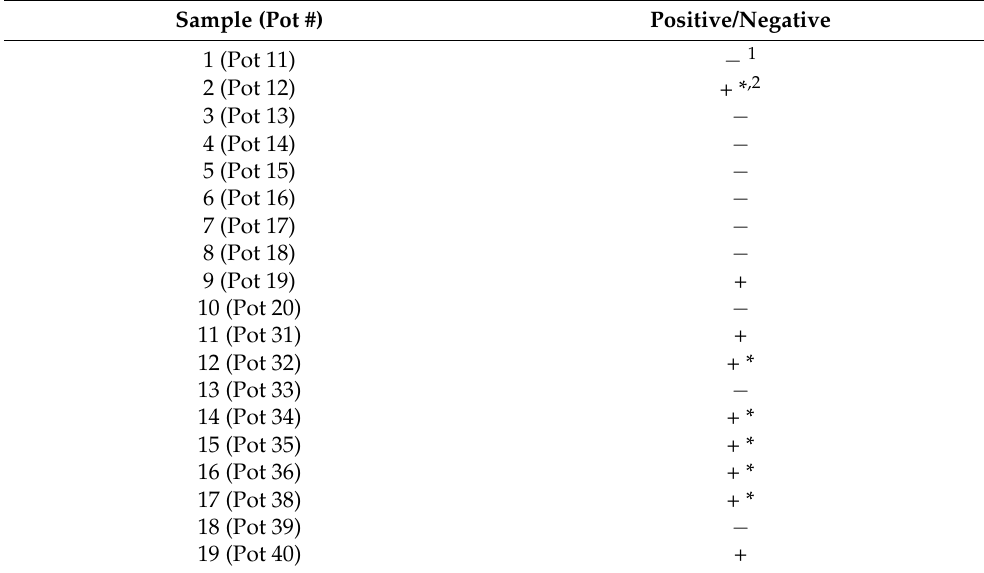
Table 3. N. benthamiana plants sown into CGMMV infested soil and tested for the presence of CGMMV.